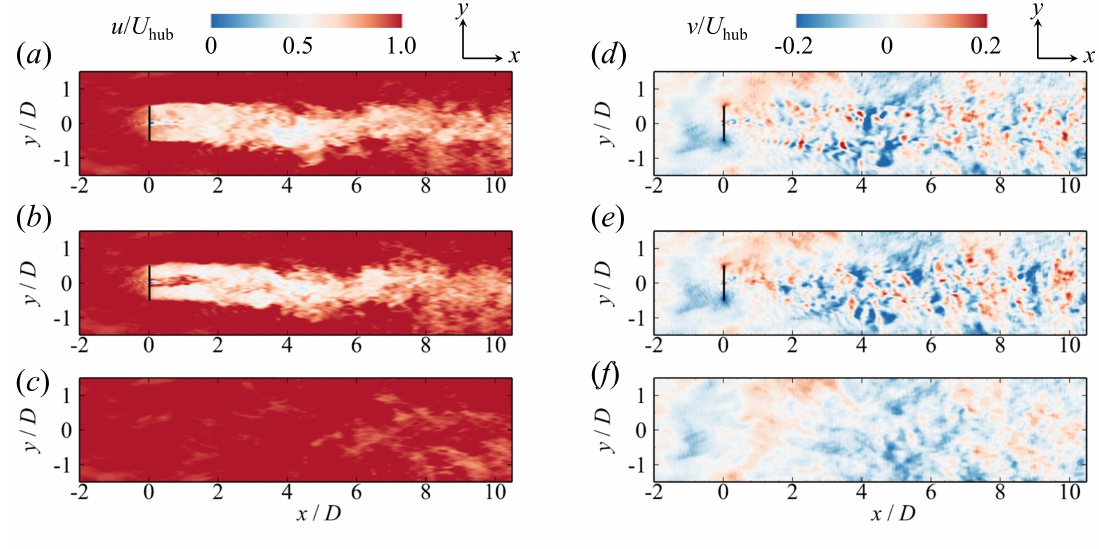
Figure 5. Turbulent inflow: contours of the instantaneous velocity field behind the wind turbine on the horizontal plane at hub height. ( a ) streamwise velocity using AD; ( b ) streamwise velocity using AS; ( d ) spanwise velocity using AD; ( e ) spanwise velocity using AS. The solid black line at x = 0 illustrates the location and the diameter of the wind turbine; ( c , f ) streamwise and spanwise velocity of the turbulent inflow without wind